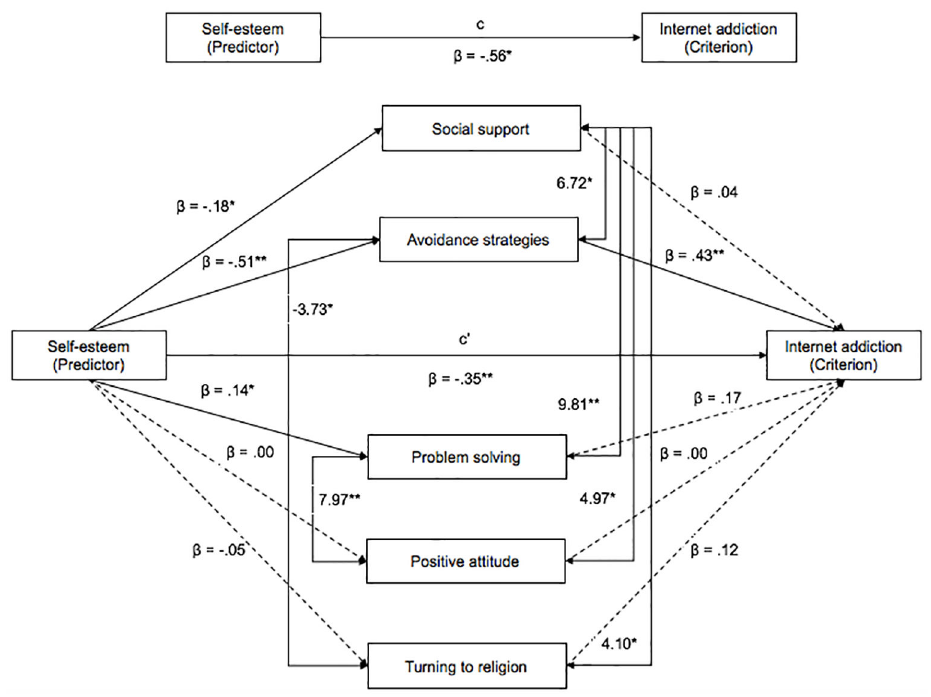
Figure 1. Visual representation of the mediation model including unstandardized results. Note . The model reports both the significant (continuous lines) and not significant (dotted lines) relationships. The covariance relationships among the coping variables and the related values are depicted as well. * p <.05. ** p <